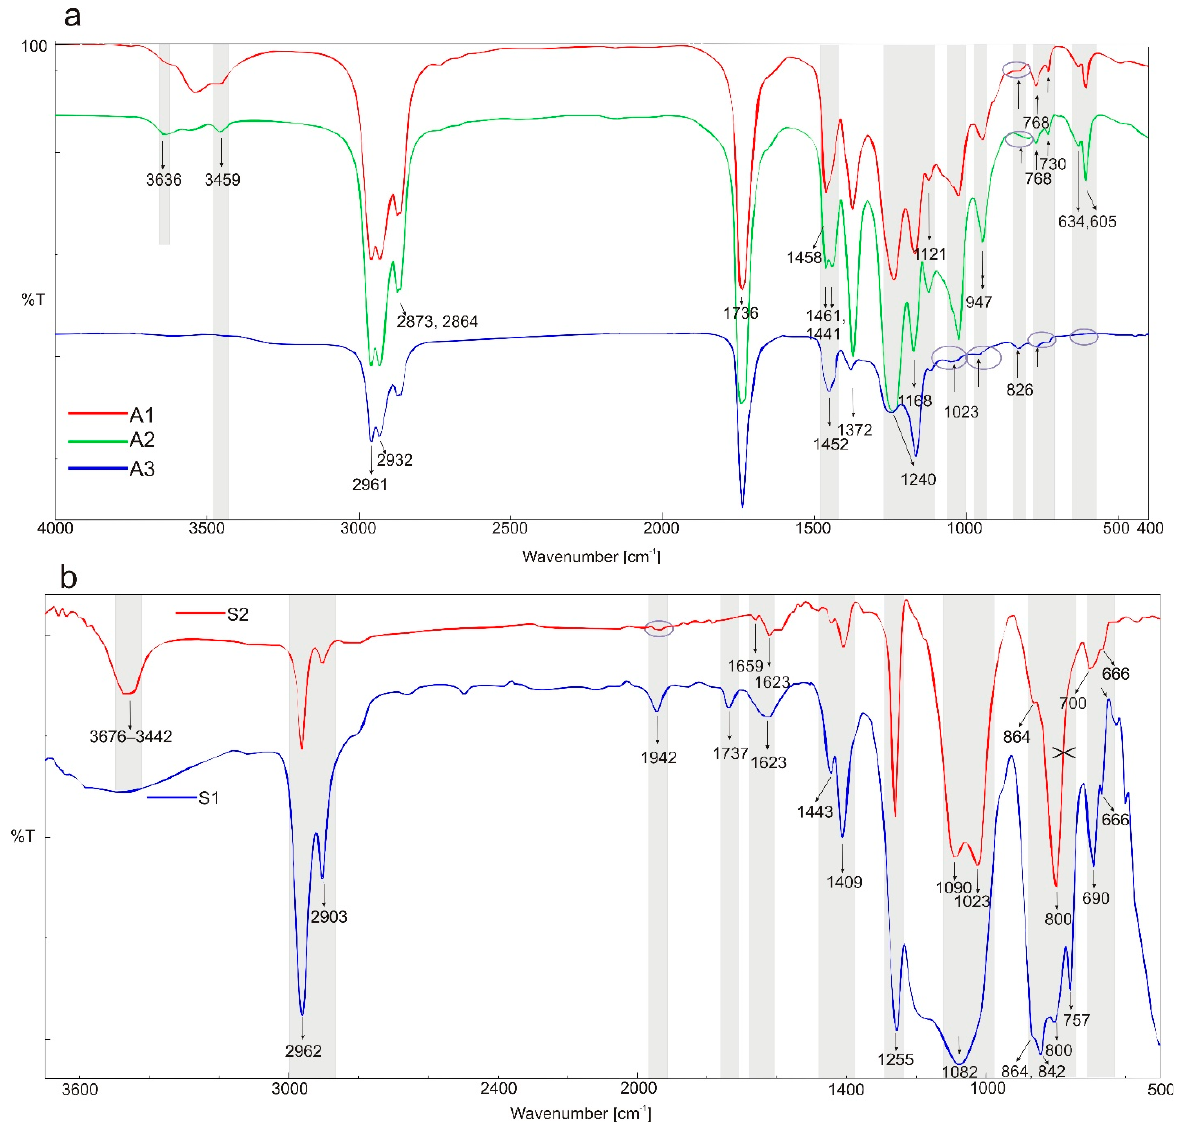
Figure 1. FTIR spectra of the investigated placebo patches: ( a ) polyacrylates; and ( b ) polysiloxanes. The grey bands mark differences or similarities between the polymers’ spectra. Table 3. FTIR identification of IND (a), CYT (b) and TST (c) in the polymeric matrices (bands or wavenumber ranges underlined are characteristic of API identification in respective patches and not present in placebo polymer film) [19–22].